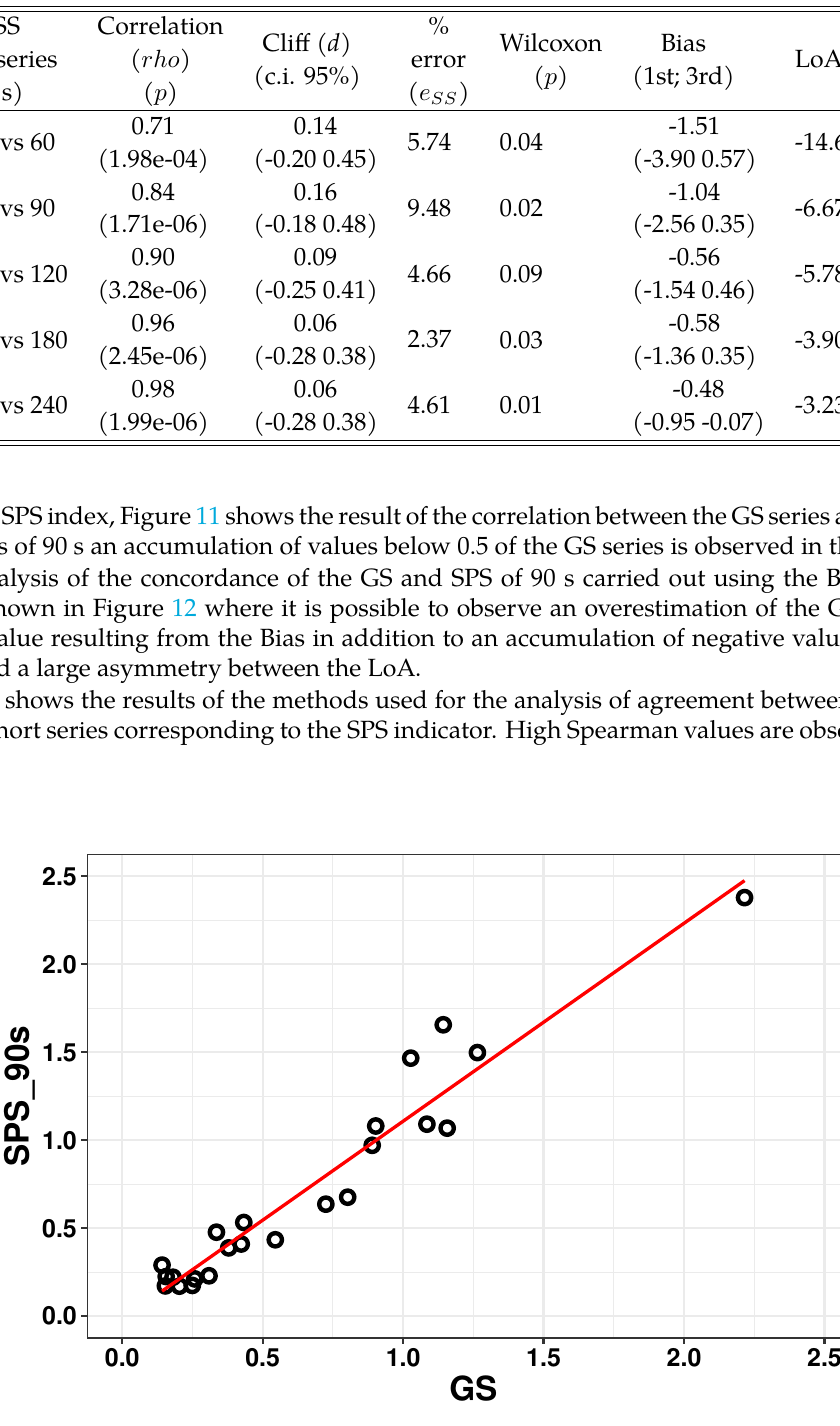
Figure 11: Correlation analysis of GS vs SPS 90 s of SPS index, rho = 0 . 93 , p =